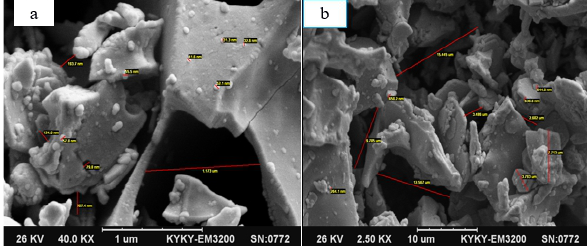
Fig. 3. SEM images of activated carbon; a) unmodified; b) modified with ZnO nanoparticles